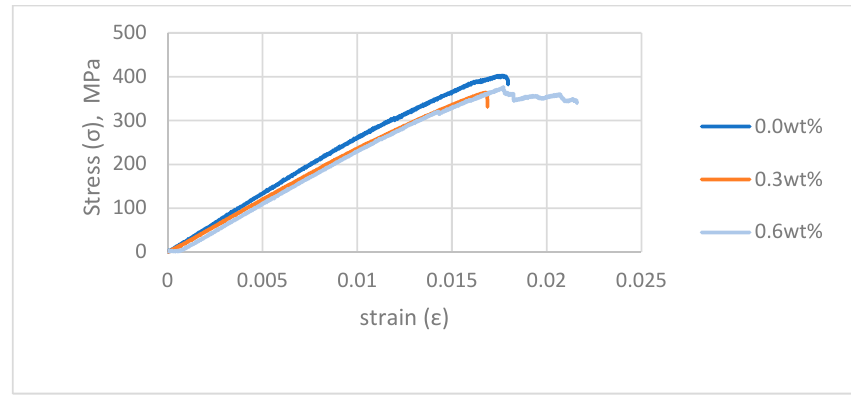
Figure 11. The representative stress-strain curves of 25 mm composites.